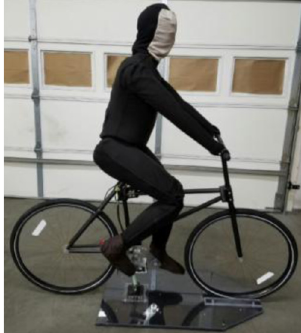
Figure 18 Prototype of the surrogate